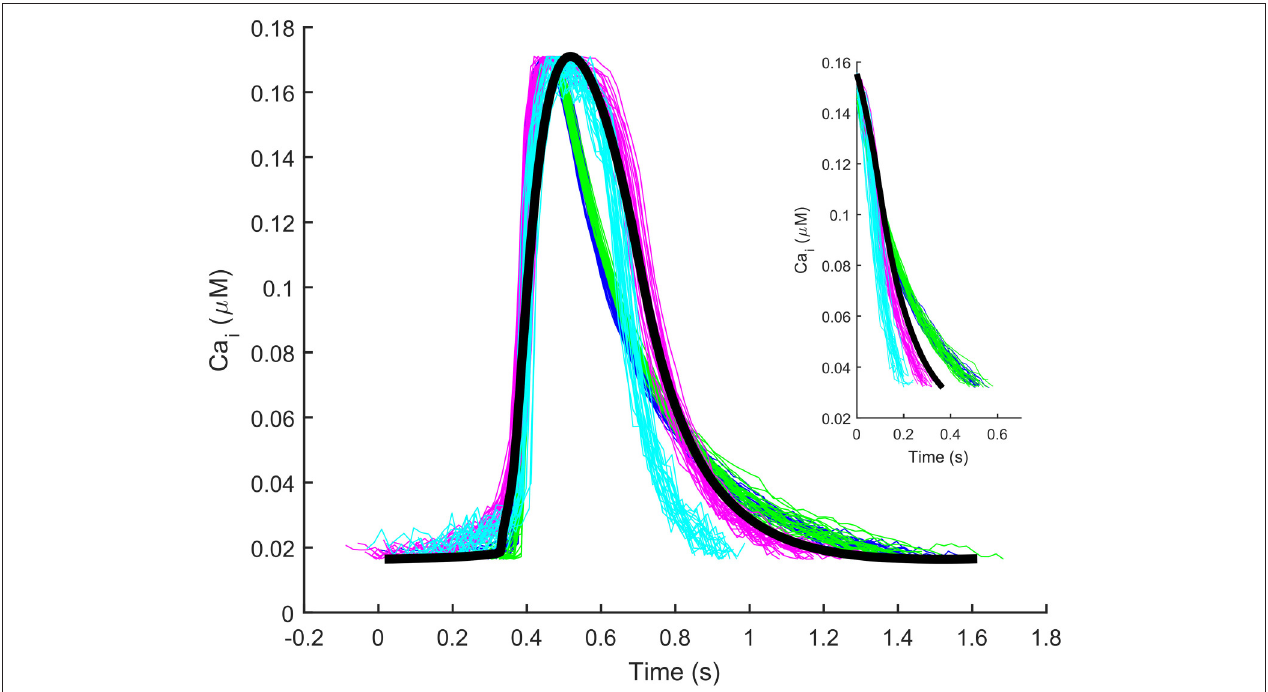
FIGURE 2 | Illustrative experimental Ca 2 + transients from four cells (blue, cyan, green, magenta) and the Ca 2 + transient simulated by the Paci2018 model (black). The y-axis of the experimental traces (originally 1 F/F) was normalized between the minimum and maximum values of the simulated trace for comparison. The inset contains only the decay part (from 90 to 10% of the transient amplitude) of the experimental and simulated transients reported in the main